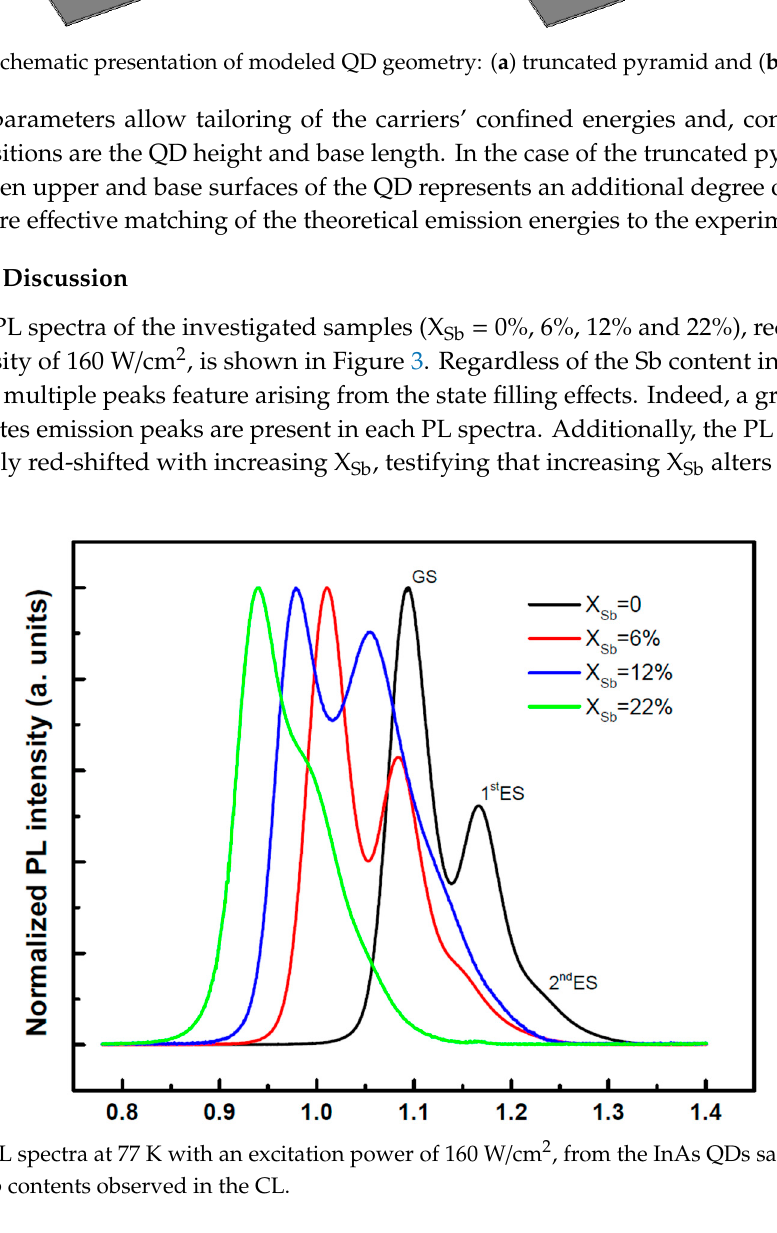
Figure 3. PL spectra at 77 K with an excitation power of 160 W/cm 2 , from the InAs QDs samples with different Sb contents observed in the CL.